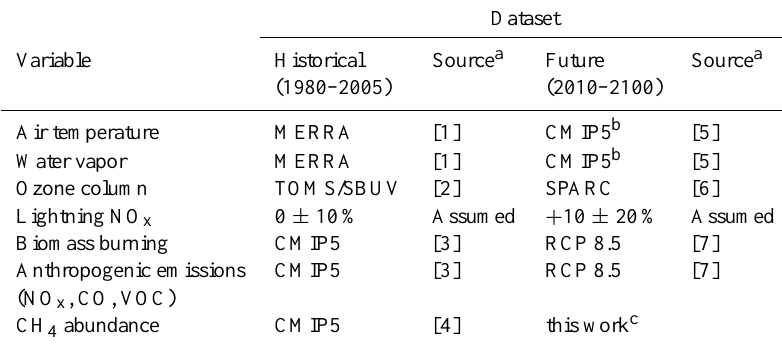
Table 3. Datasets used to calculate historical and future τ CH